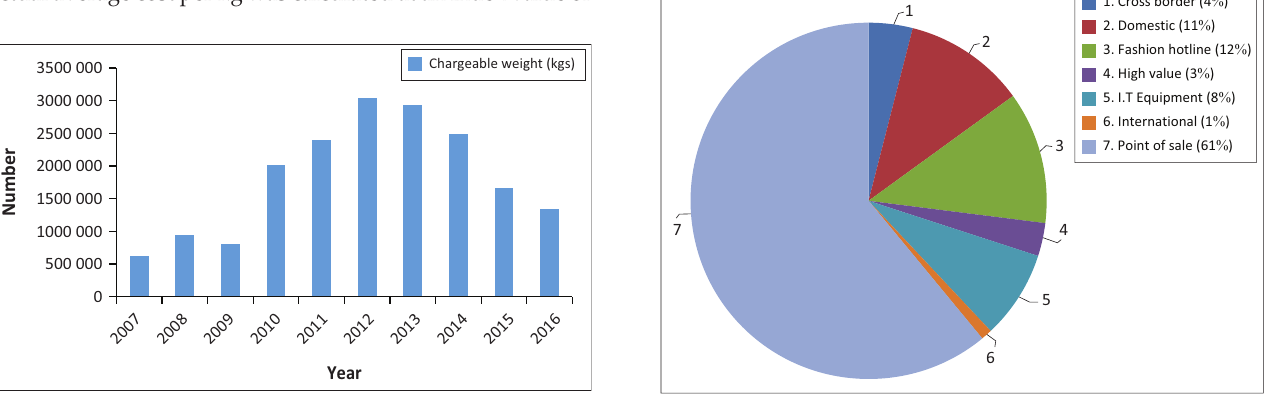
FIGURE 5: Total annual volumes – May 2007 to December 2016. FIGURE 6: Contribution to total volumes of each product category.